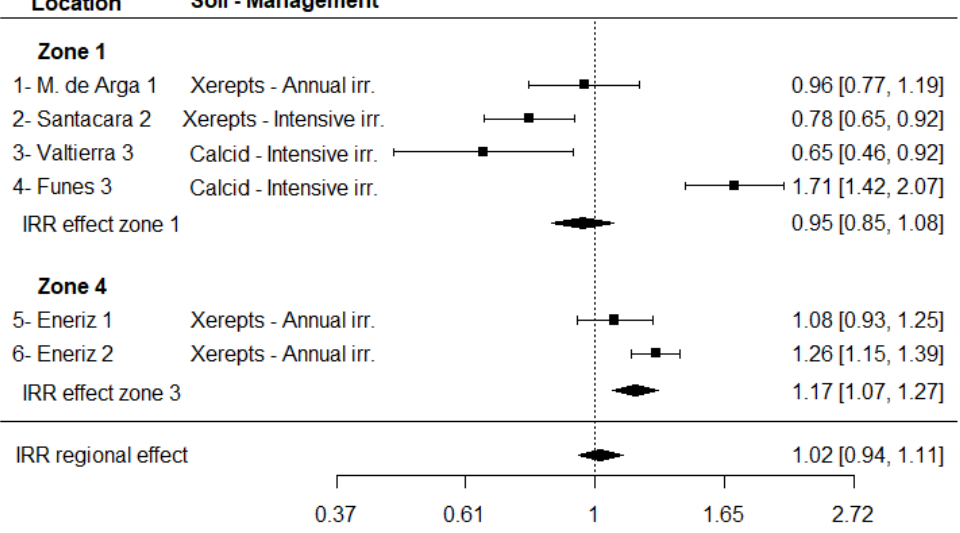
Figure 14. Response ratio (RR) of AWHC (0–30 cm) for the adaptive management strategy of irrigation (IRR). Zones correspond to those in Figure 1. The effect was considered significant when the 95% confidence interval (CI) of the RR did not overlap one ( α = 0.05). Soil and management column includes information about principal soil group and irrigation regime considered in each group.